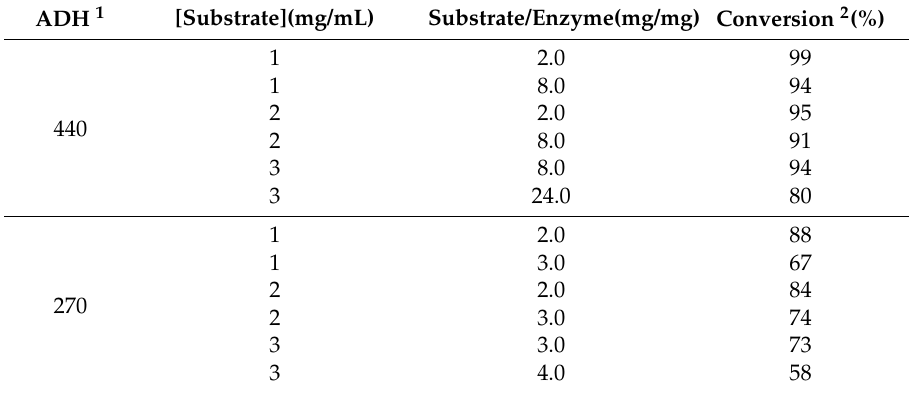
Table 2. Effect of substrate concentration and substrate/enzyme ratio on conversion for the ADH-mediated reduction of 3a